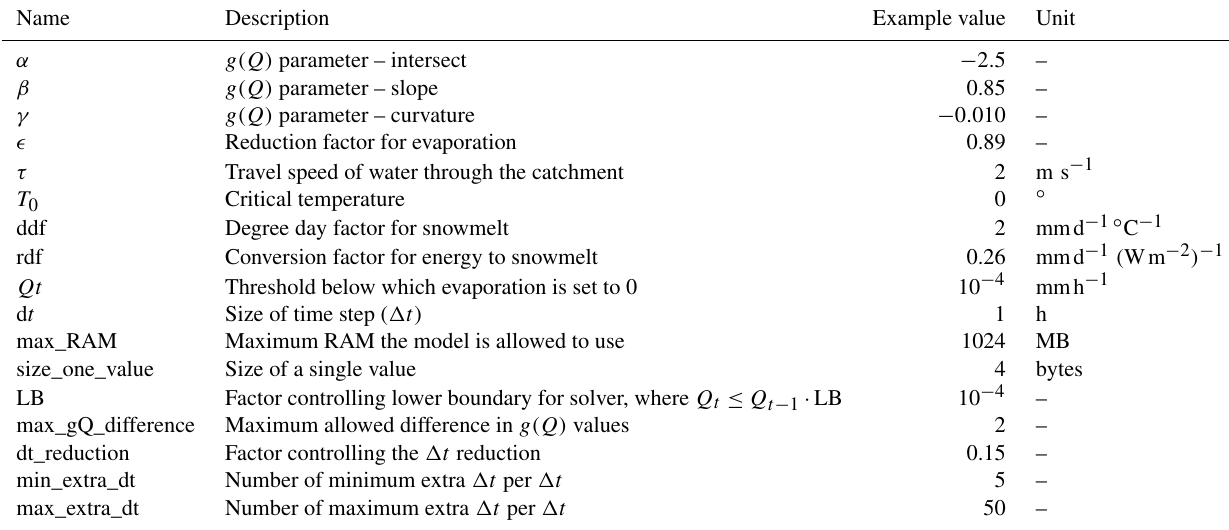
Table A1. List of dS2 parameters. All parameters after rdf only influence the numerical stability and/or the I/O operations of the model, not the model